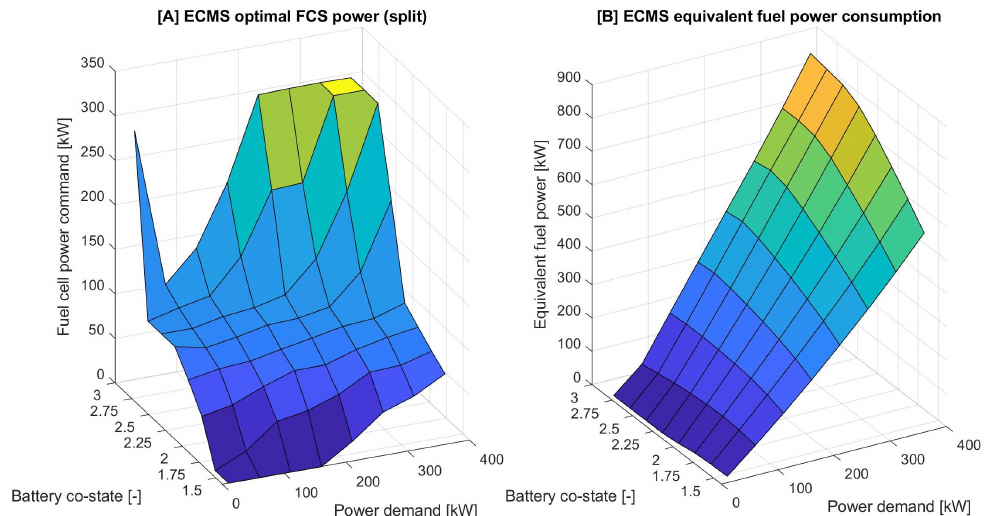
Figure 7. ( A ) ECMS optimal FCS power and ( B ) equivalent battery corrected fuel power consumption for the current 40T FCEV truck use case as a function of overall traction-auxiliary power demand and battery co-state. Lower co-state makes the battery energy cheaper and thus uses less FCS where as a higher co-state makes battery energy expensive promoting greater usage of the